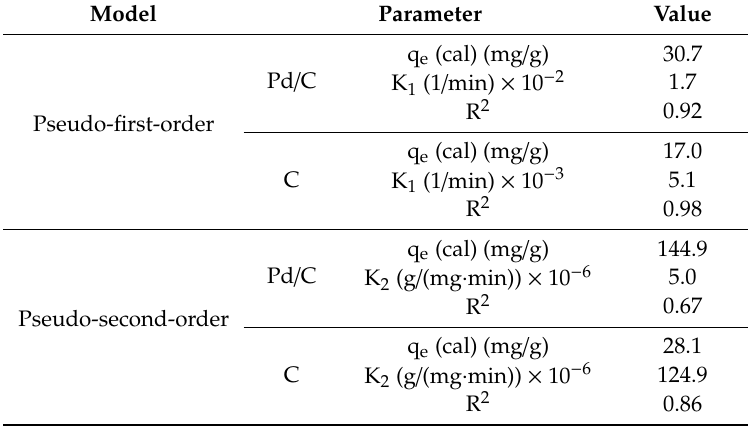
Table 2. Kinetics parameters for MO adsorption onto Pd / CNF and CNF samples calculated with the pseudo-first-order and pseudo-second-order